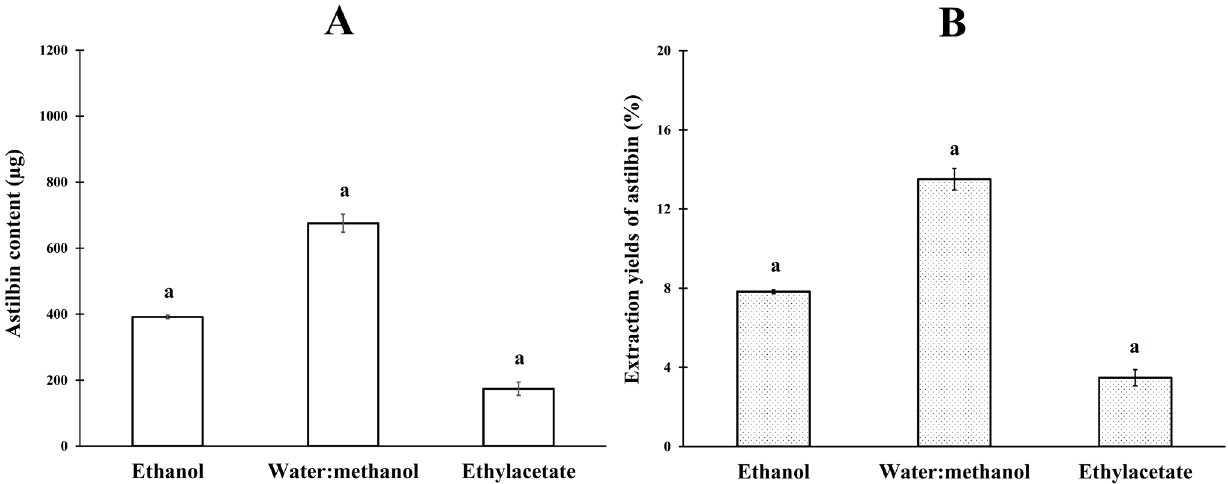
FIGURE 4 - (A) Astilbin content and (B) extraction yields of astilbin using 300 W of microwave power level and six cycles of microwave-assisted extraction in different solvents: ethanol, water:methanol (40:60), and ethyl acetate. The extraction yields of astilbin were calculated as dry powder of L. strychnifolium stems. a significantly different ( p < 0.05